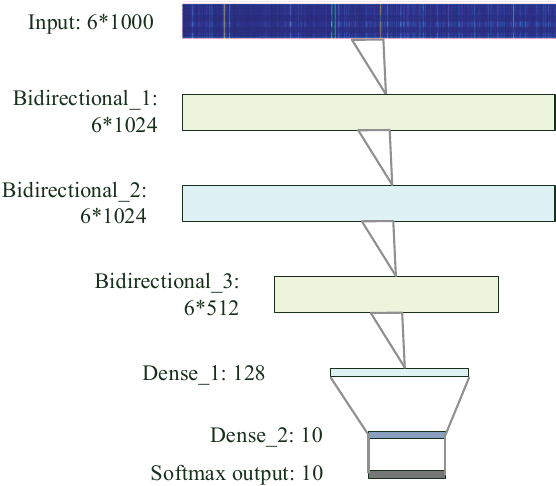
Figure 9. Bidirectional Long Short-Term Memory (bLSTM) architecture to decode silent